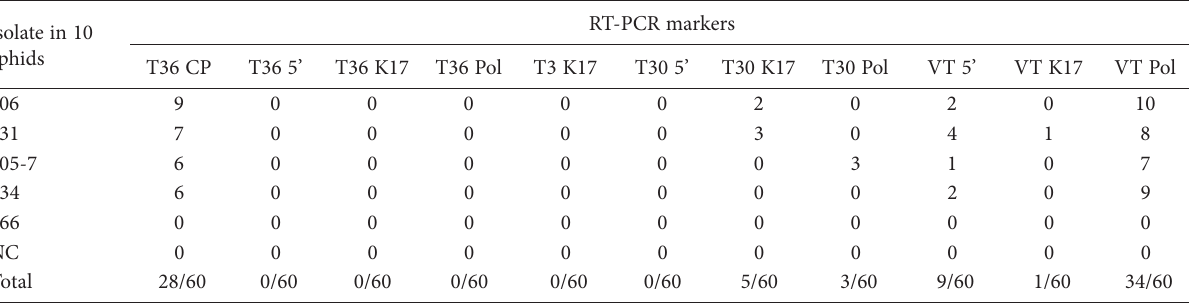
Table 4. Frequency of amplified markers patterns in groups of ten Aphis gossypii individuals during the transmission assays of Chilean CTV isolates.